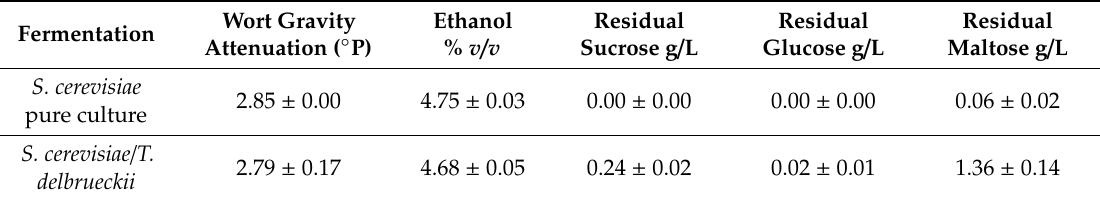
Table 1. The main analytical characteristics of the beer produced by pure and mixed fermentations.